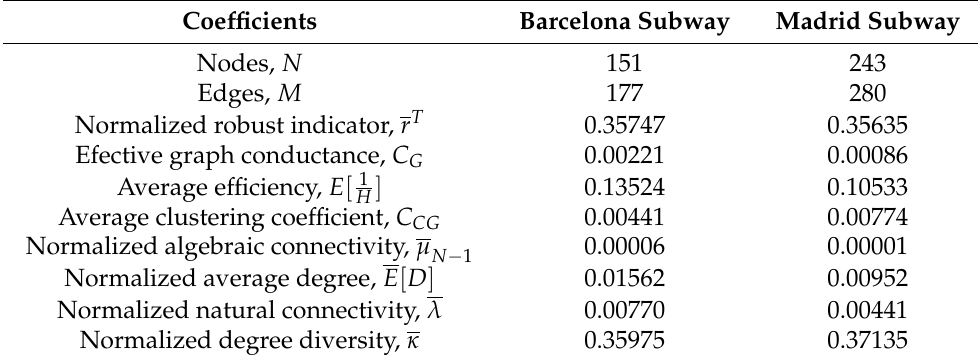
Table 5. Robustness metrics in Barcelona and Madrid subway networks.